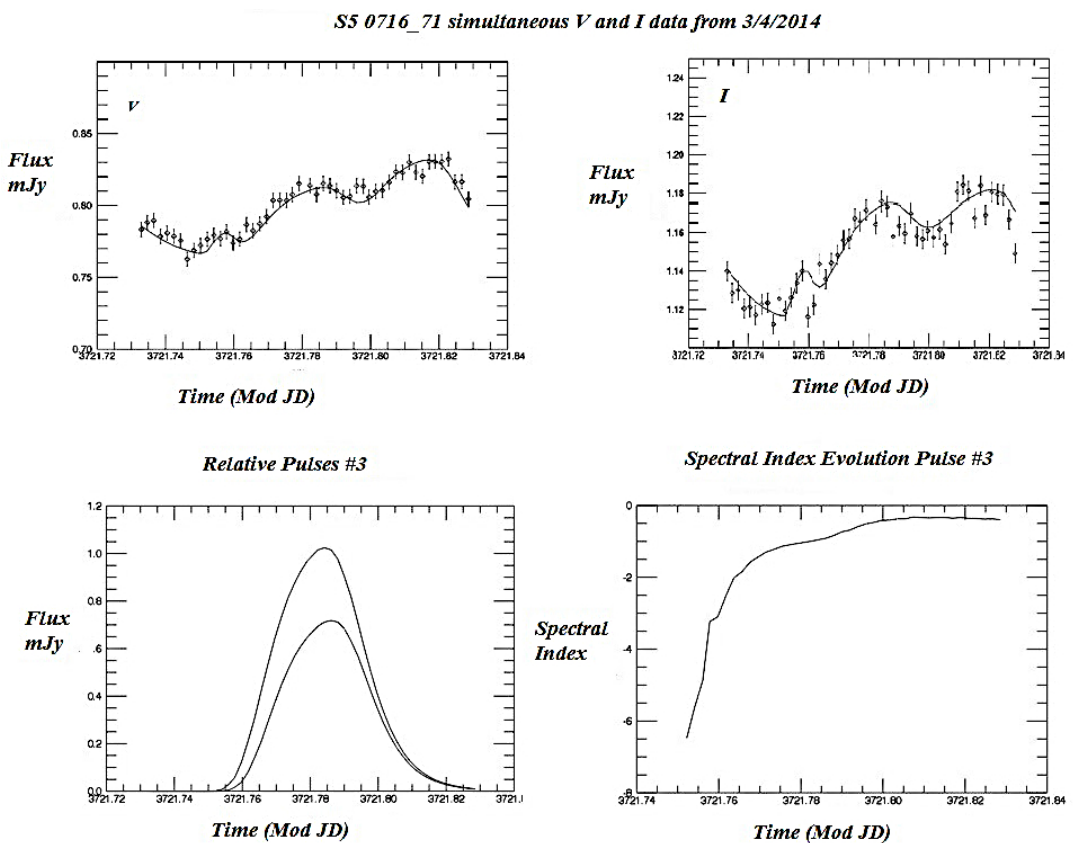
Figure 7. Simultaneous optical micro-variability light curves of S5 0716+71, taken at the SARA observatory at Kitt Peak on 3/4/2014. The upper left curve was through a V filter, while the right top curve was taken through an I filter. We independently fit each of the light curves to remove bias for center times/amplitudes. We are continuing to monitor these objects to try and get additional multi-frequency micro-variability curves to further test the model against